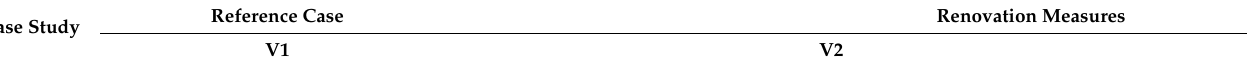
Table 3. Renovation packages: adapted from